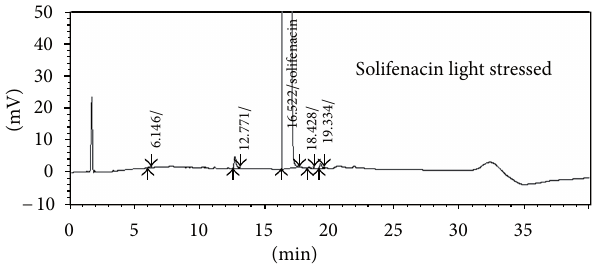
F 9: Typical HPLC chromatogram of water stressed solution.